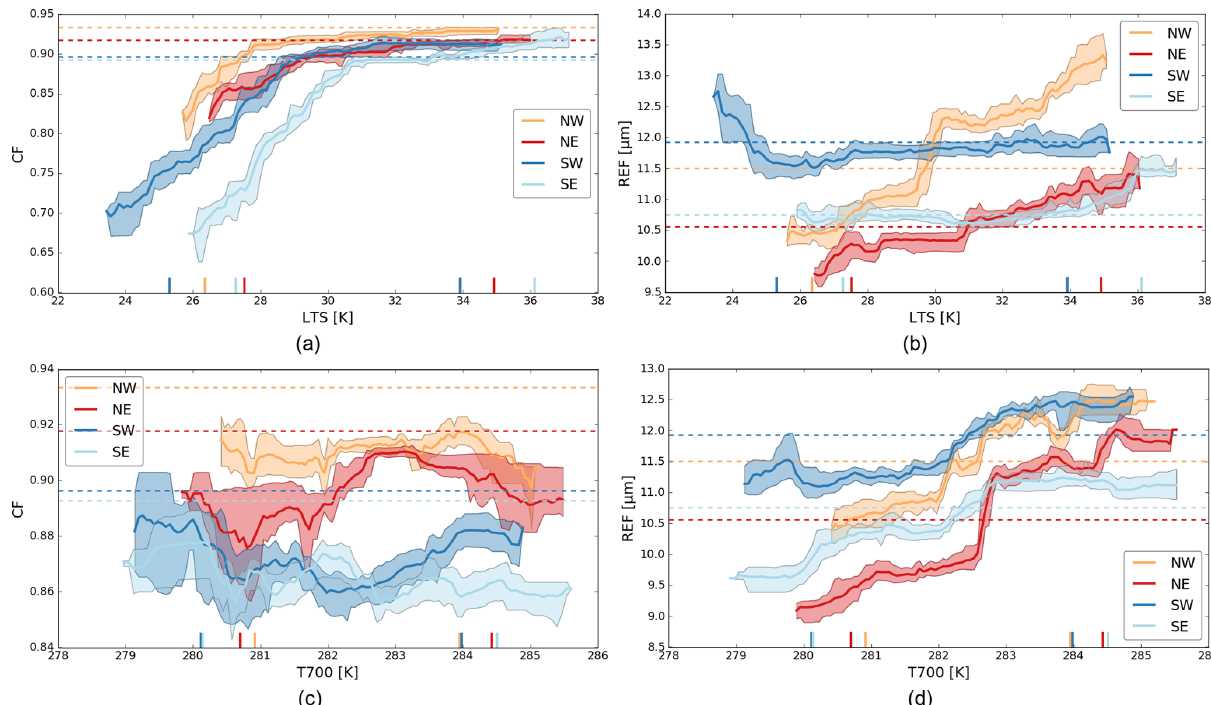
Figure 3. Mean partial dependence of CF and REF on LTS (a, b) and T700 (c, d) in the four subregions (colors) during JAS. Shaded areas mark minimum and maximum partial dependence obtained from all model runs. Horizontal dashed lines show the predicted mean. Vertical tick marks on the x axis indicate 5th and 95th percentile of the